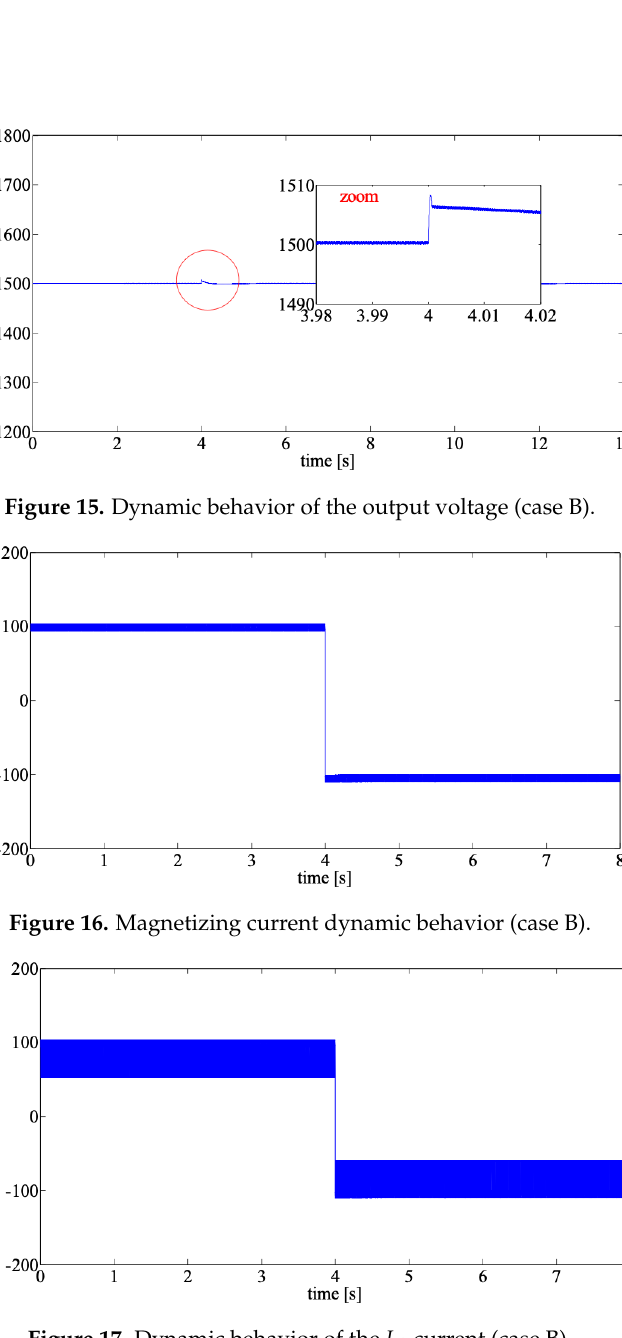
Figure 17. Dynamic behavior of the L 1 current (case B).